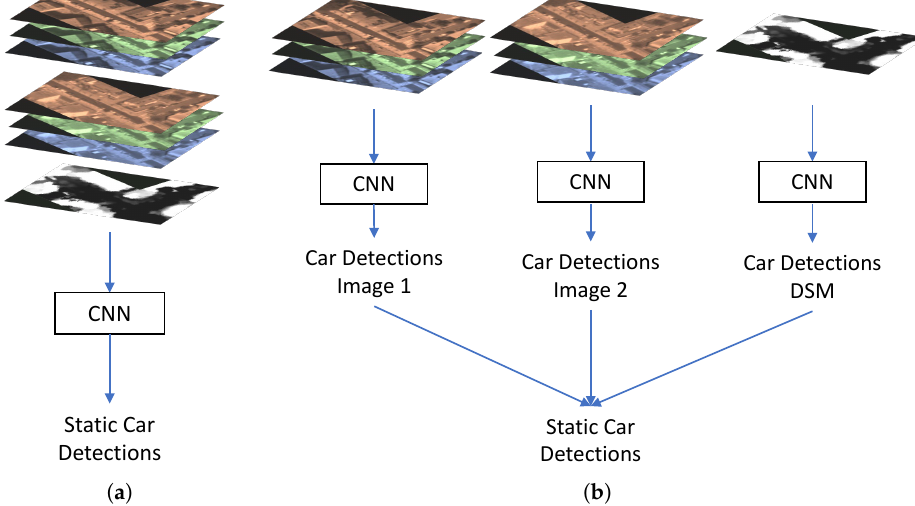
Figure 5. The two fusion mechanism investigated in this paper: ( a ) early fusion and ( b ) late